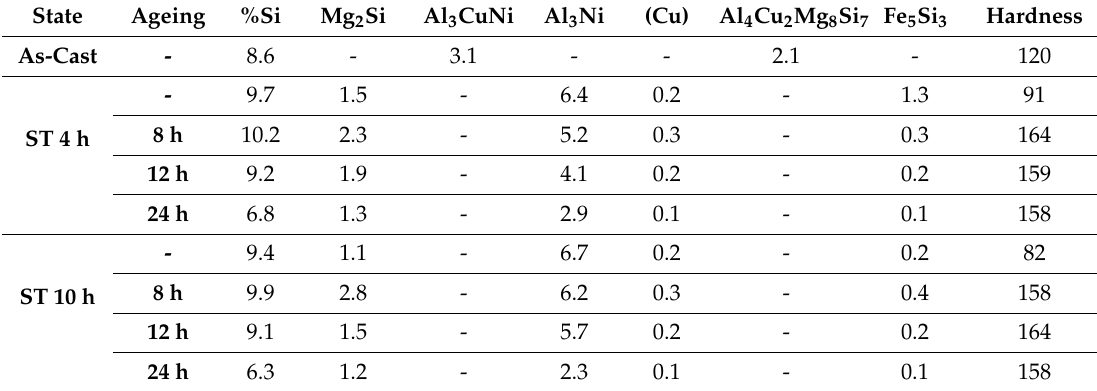
Table 2. Weight proportion of the crystalline phases present after thermal treatments. Rest: α -phase. (ST: solution